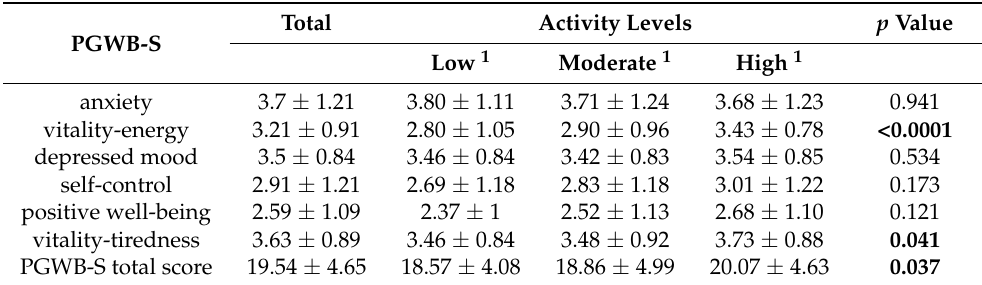
Table 3. Psychological General Well-Being index—Short version (PGWB-S) results. The table shows PGWB-S total score and subitems for the whole sample, as well as according to PA